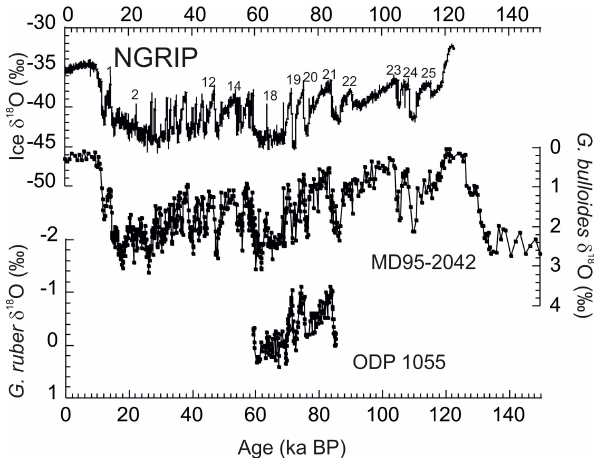
Figure 2. Age models of MD95-2042 and ODP 1055 established by tying planktonic foraminifera oxygen isotope changes of Glo- bigerina bulloides (MD95-2042; Shackleton et al., 2000) and Glo- bigerinoides ruber (ODP Site 1055) to those of NGRIP. Sev- eral Dansgaard-Oeschger interstadial events are numbered in the NGRIP